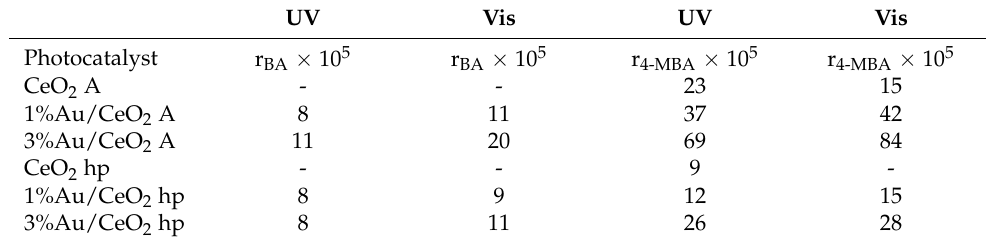
Table 4. Photoactivity results in terms of degradation rate of benzyl alcohol (r BA ) and 4- methoxybenzyl alcohol (r 4-MBA ) expressed in [mM · min − 1 ], both under UV or visible light